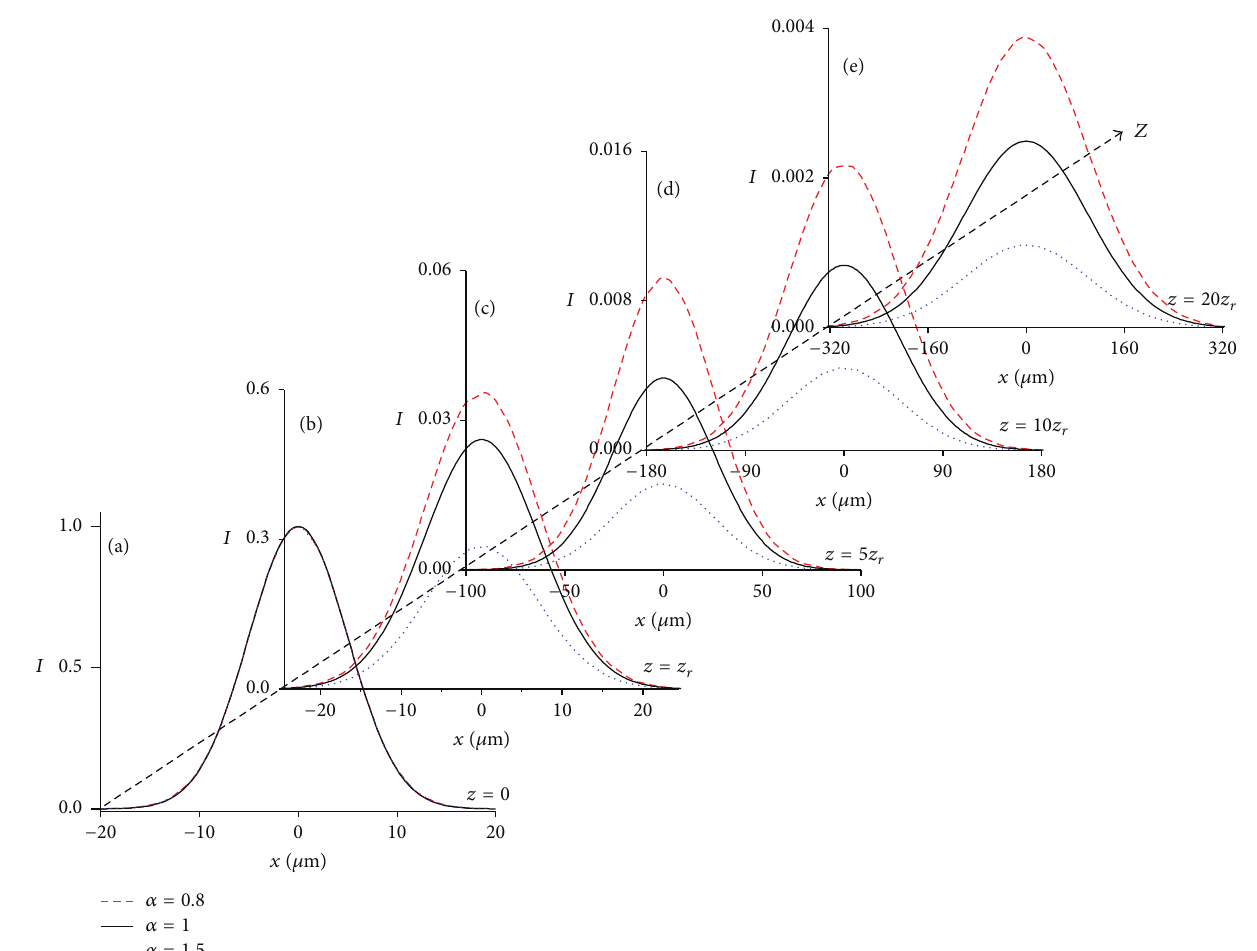
𝛼 : 𝛼 = 0.8 (dashed curve); 𝛼 = 1 (solid